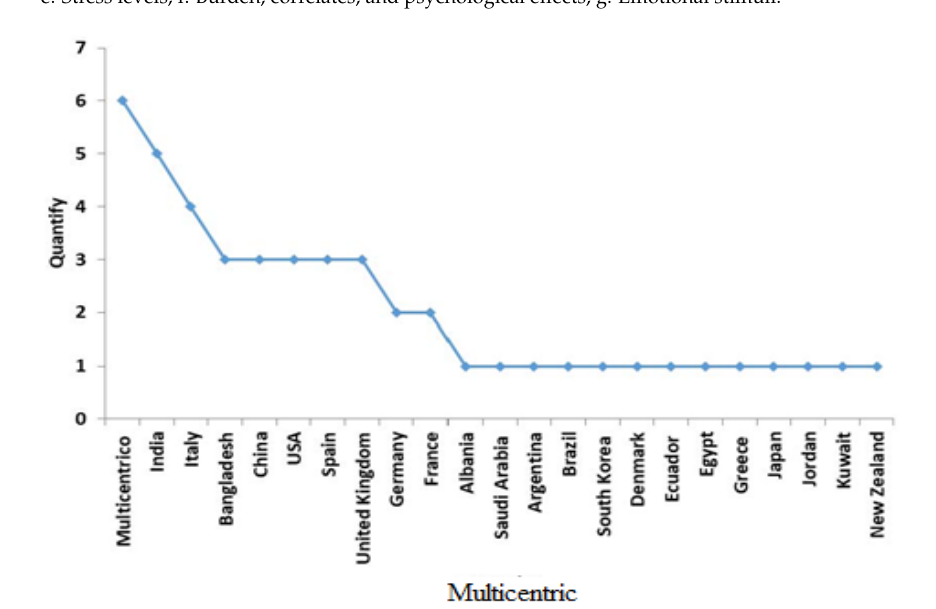
Figure 2. Number of contributions of original articles published on mental health by country during the pandemic